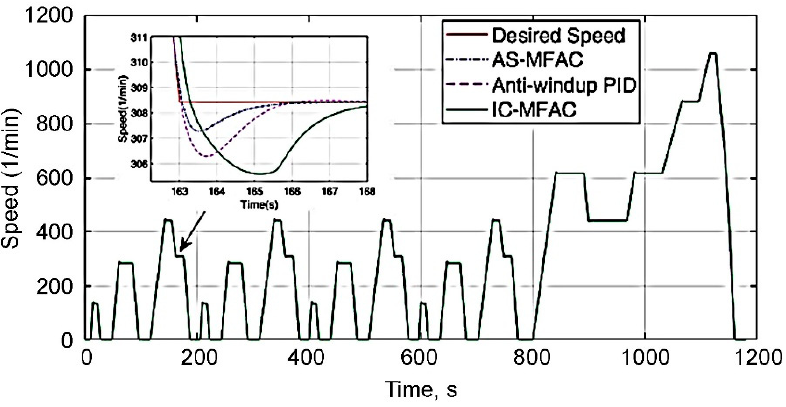
Figure 5. The curve of car speed changes by three different algorithms.